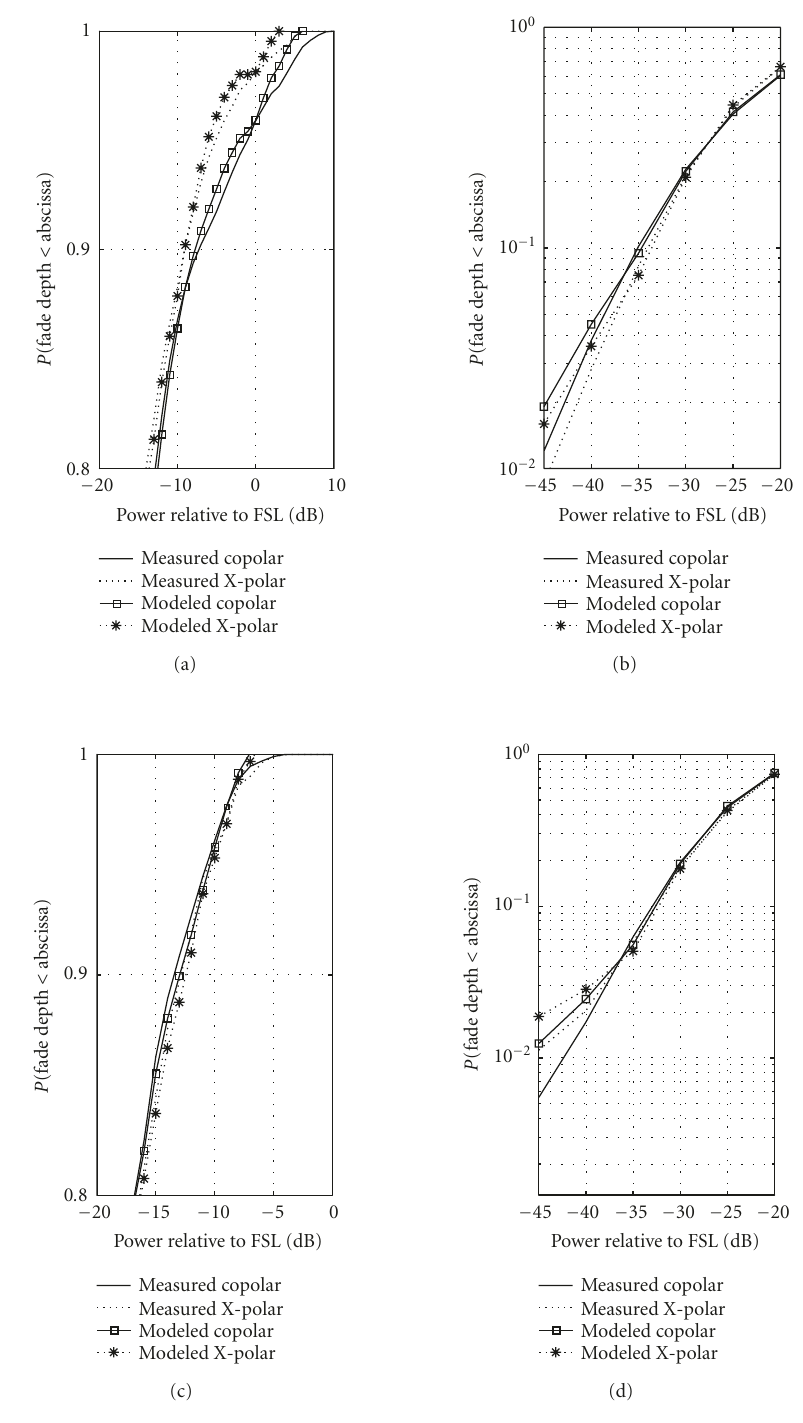
Figure 3: Comparison of modeled and measured cumulative distributions; upper figures: highway channel; lower figures: urban channel.